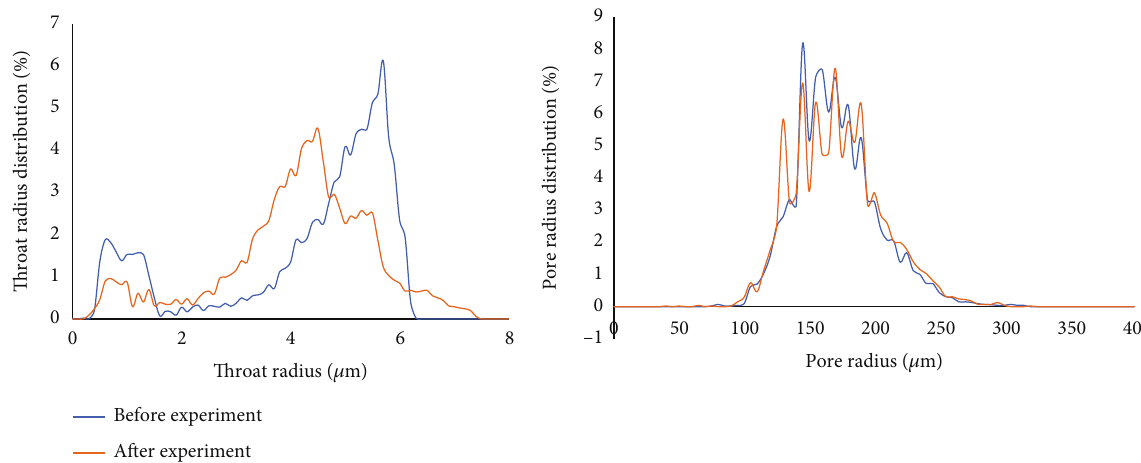
Figure 10: D2 distribution of pore and throat before and after core experiment.